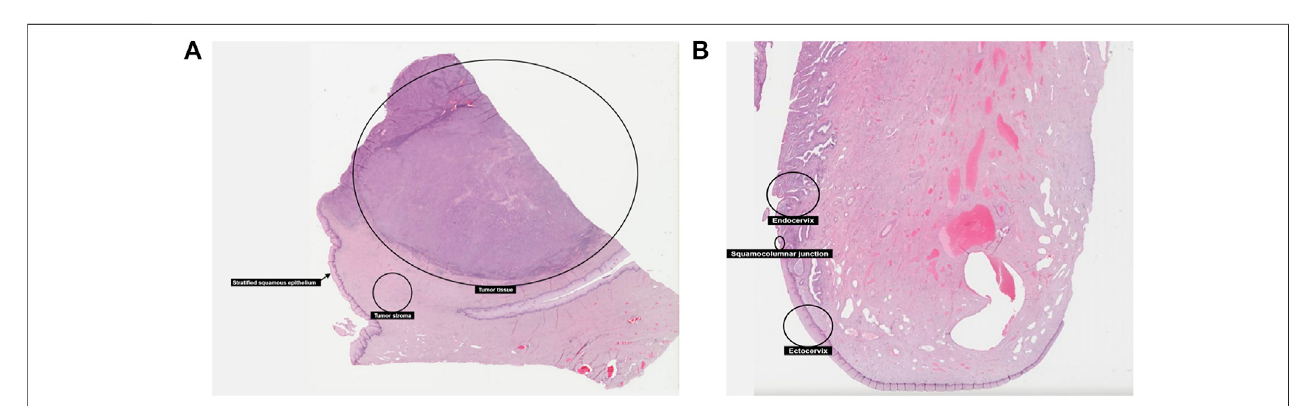
FIGURE 4 | In HPA, the proliferation of malignant cells in tumor tissue.